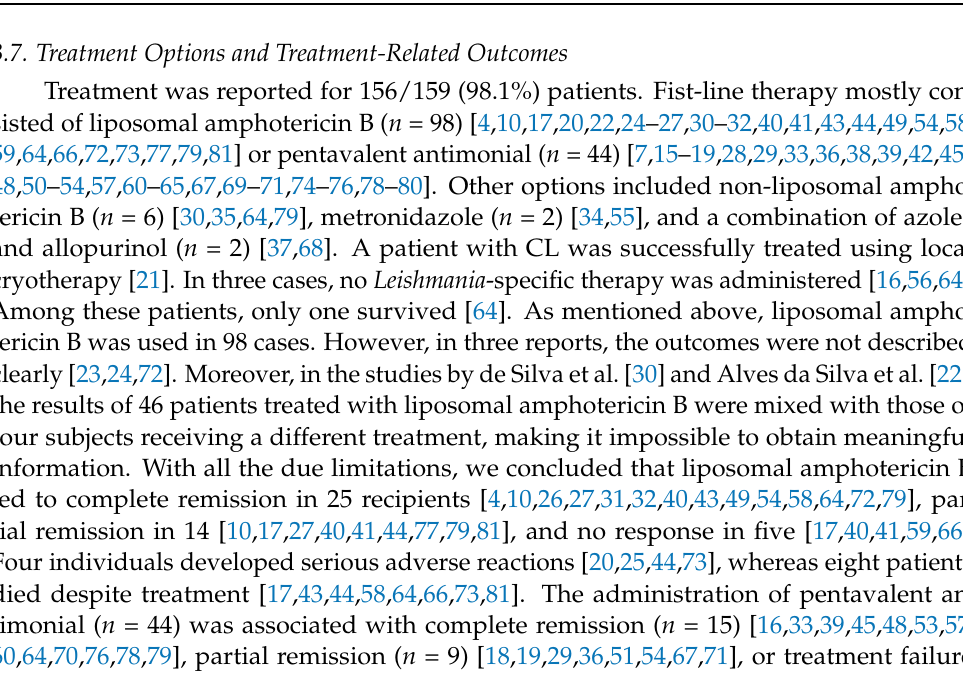
Table 4. Summary of the patient- and transplant-related outcomes of the case reports and case series of Leishmania infection after kidney transplantation (summaries based on individual cases should not be considered as an estimate of the “real world”). Patients Outcome ( n = 159) Alive 131 Dead 26 Data not available